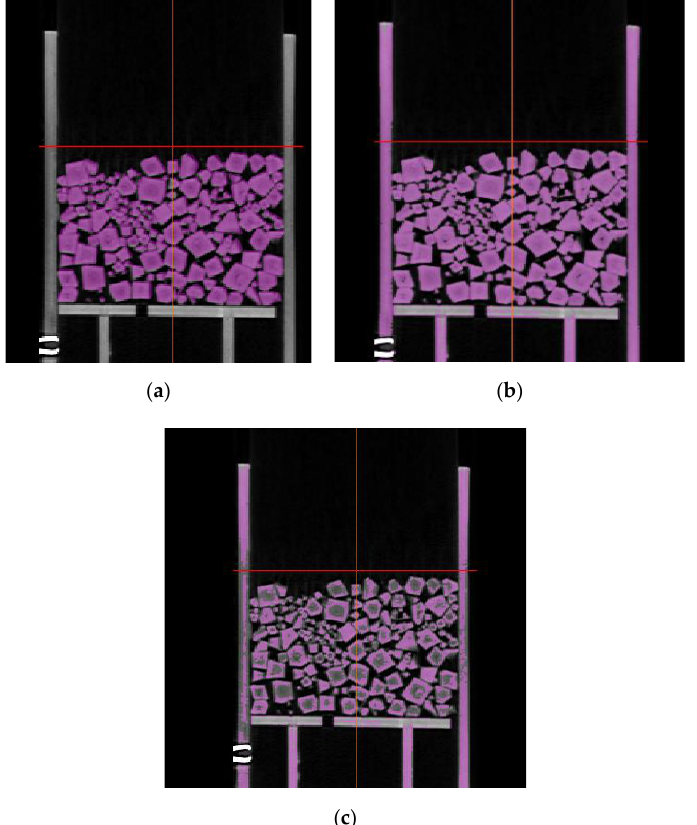
Figure 10. Results of the segmentation of the same CT image of O1 via different methods. ( a ) The SVM method. ( b ) The gray-scale morphology method. ( c ) The histogram segmentation method.